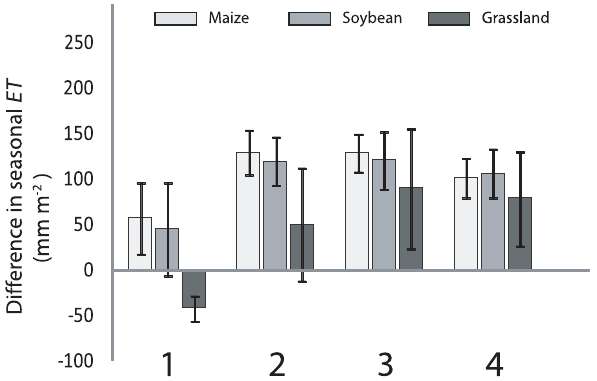
Fig. 8. Implications from choices of methods of determining grow- ing season parameters: (1) Differences between observed and es- timated season duration from EDPM; (2) Differences between ob- served and estimated season duration from retrospective MODIS time series; (3) Differences between observed and estimated season duration from AVHRR based climatologies; and (4) Differences be- tween observed and estimated season duration from MODIS based long term averages. Error bars show standard